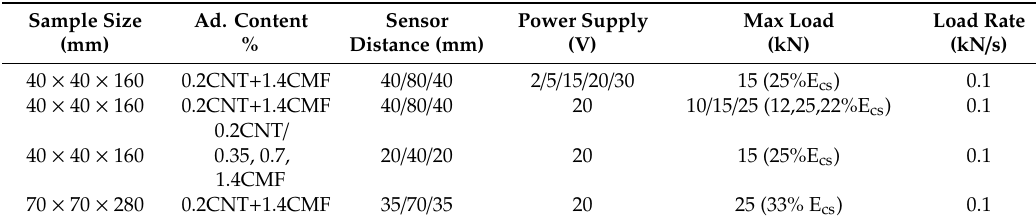
Table 5. Variables for the PZR of self-sensing performance.